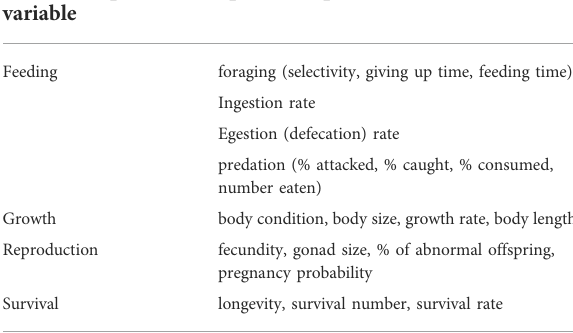
TABLE 1 Summary of the general categories of organism responses to microplastic exposure, and the speci fi c description of response variables that comprise